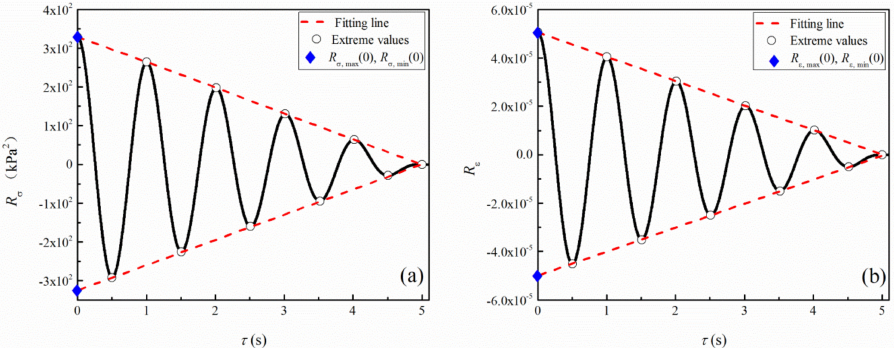
Figure 5. Schematic representation of the autocorrelation functions of stress ( a ) and strain ( b ) time